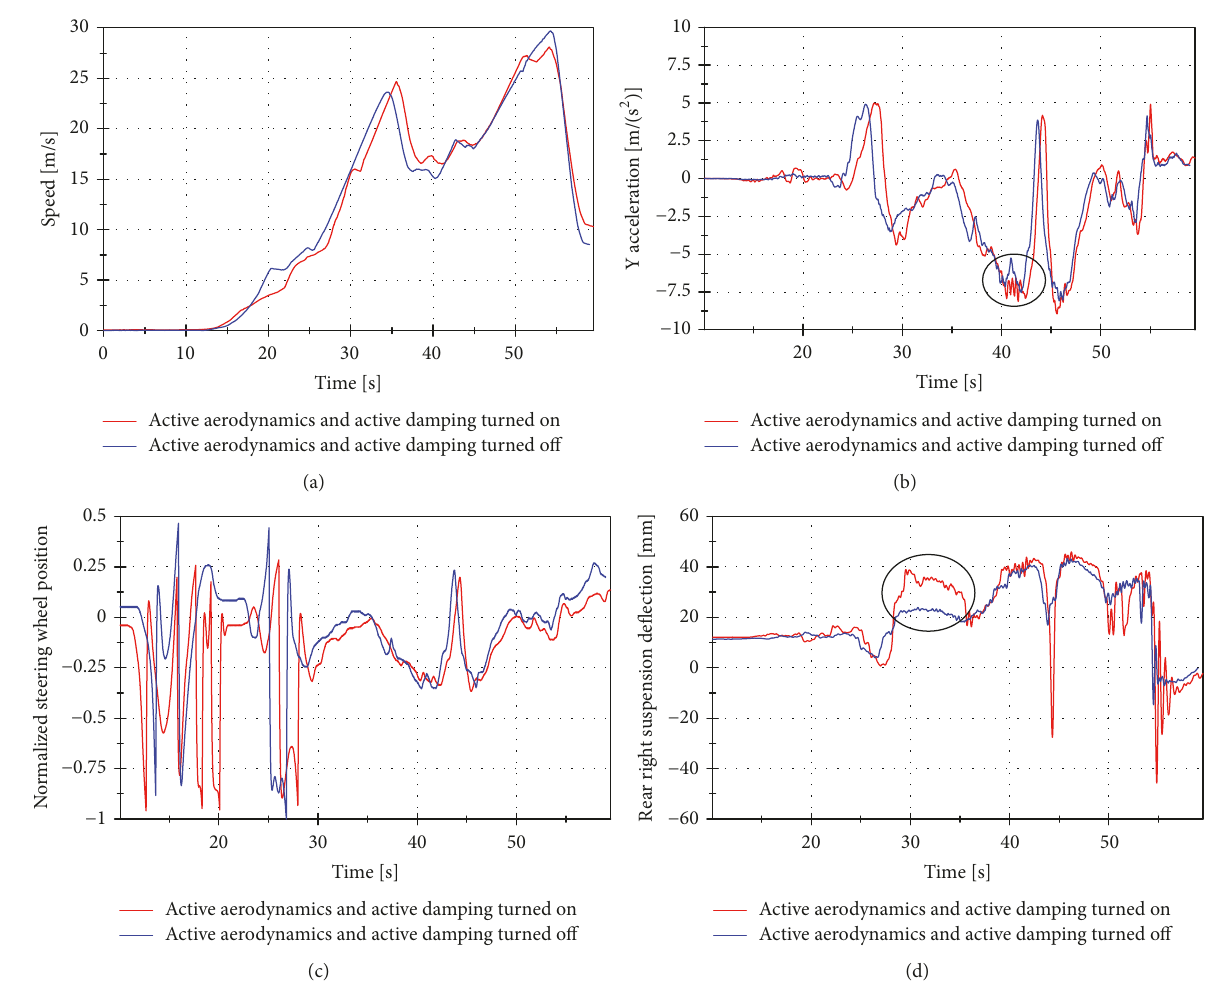
Figure 24: (a) Speed. (b) Lateral acceleration. The suspension instability is marked with a circled area. (c) Steering wheel position. (d) Rear right suspension deflection. The differences in the deflections are marked with a circled